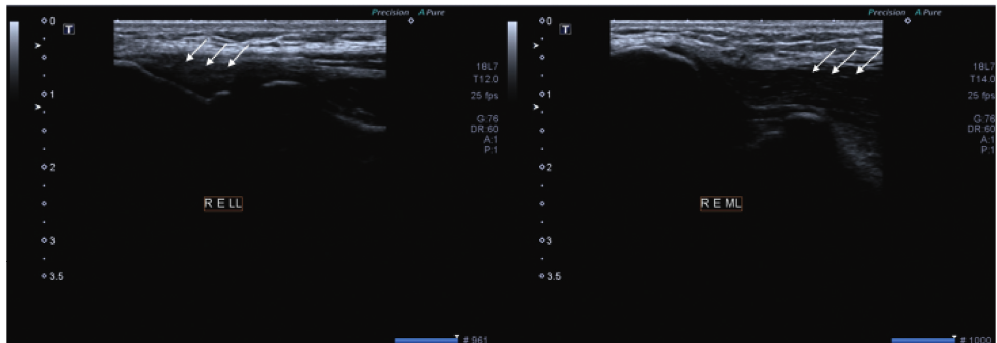
Figure 10: Tendon of right elbow joint shows thickening and hypoechogenicity representing tendonitis (white